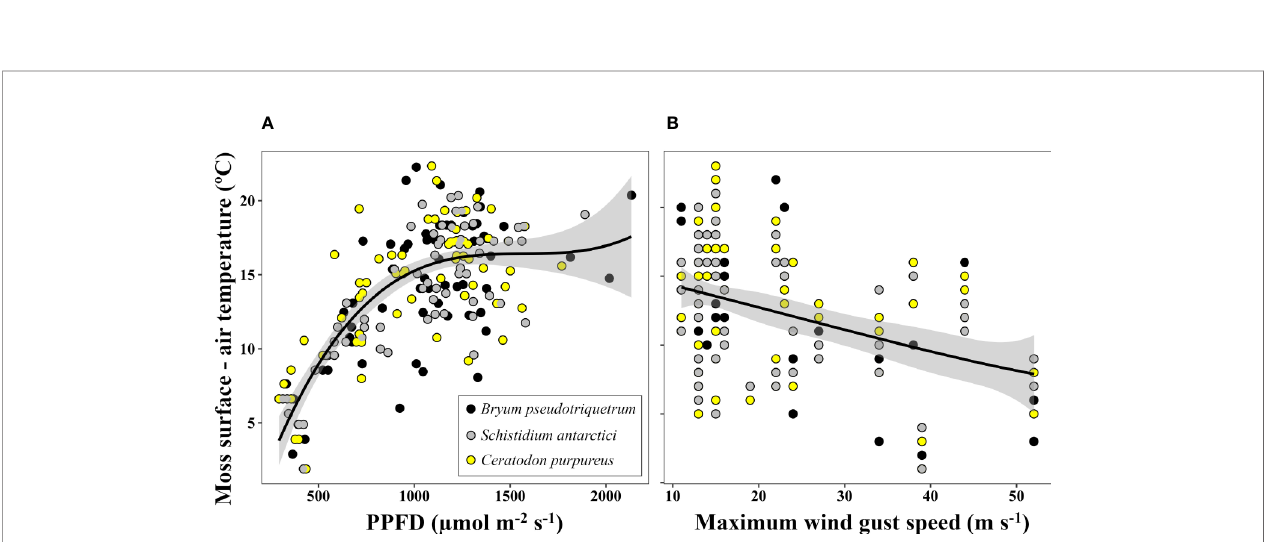
FIGURE 4 | Relationship between the increase of moss surface temperature relative to air temperature and (A) solar photosynthetic photon fl ux density (PPFD) ( P <0.05, R 2 = 0.546 for logarithmic transformed data) and (B) daily maximum wind gust speed ( P <0.05, R 2 = 0.165). Lines represent quadratic polynomial fi ttings of temperature with their respective 95% con fi dence intervals (shaded areas). Moss surface temperature and PPFD were measured at 12:00 (UTC +13) with an infrared thermometer and a LS-C mini quantum sensor, respectively. Air temperature at this time and daily maximum wind gust speed were obtained from the Australian Bureau of Meteorology at Casey station. Data represent eight days of measurement within a period of 22 days (from 09/11/2002 to 01/02/2003) at three locations (one daily measurement per species and location).